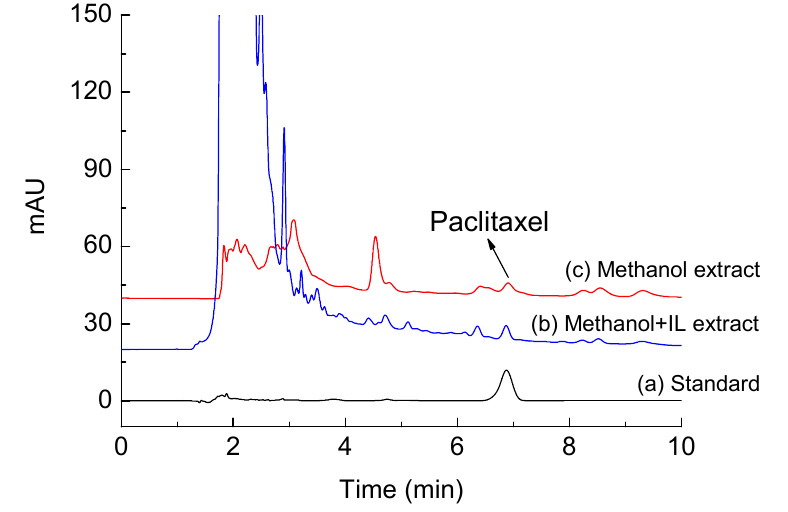
Figure 4. HPLC chromatograms for paclitaxel extracted from Taxus x media leaves. ( a ) Standard; ( b ) methanol + IL extract; and ( c ) methanol extract.